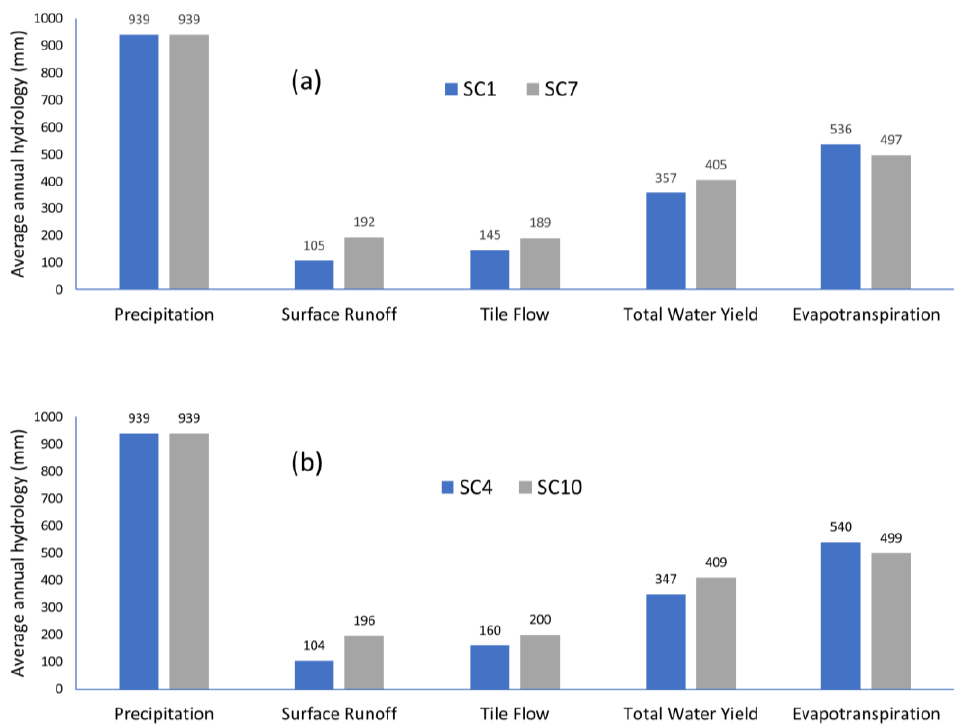
Figure 10. Annual hydrologic balance components: ( a ) comparison of scenarios SC1 and SC7 FAO soil with combination of Solaris (land use) and GCDC weather. ( b ) Comparison of scenarios SC4 and SC10 FAO soil with combination of GLCC (land use) and GCDC weather.